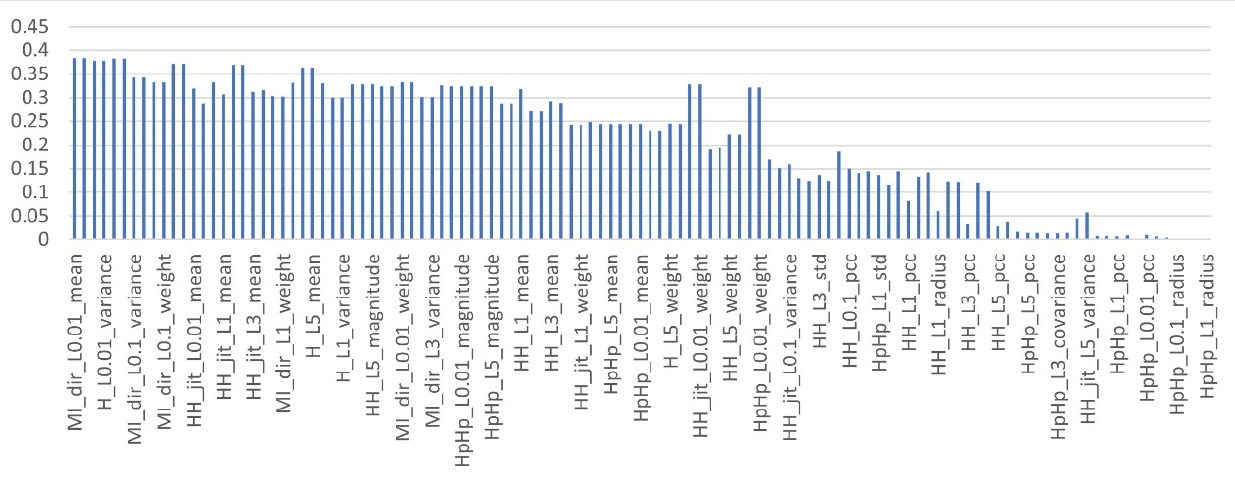
Figure 4. Mutual information of features with MAX aggregation function.